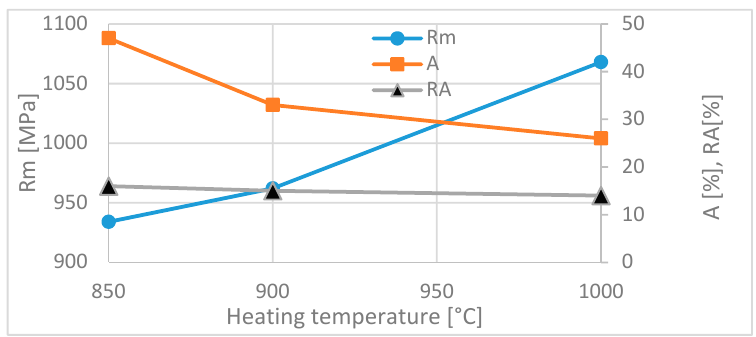
Figure 2. Effect of heating temperature on tensile strength (Rm), total elongation (A), retained austenite (RA).